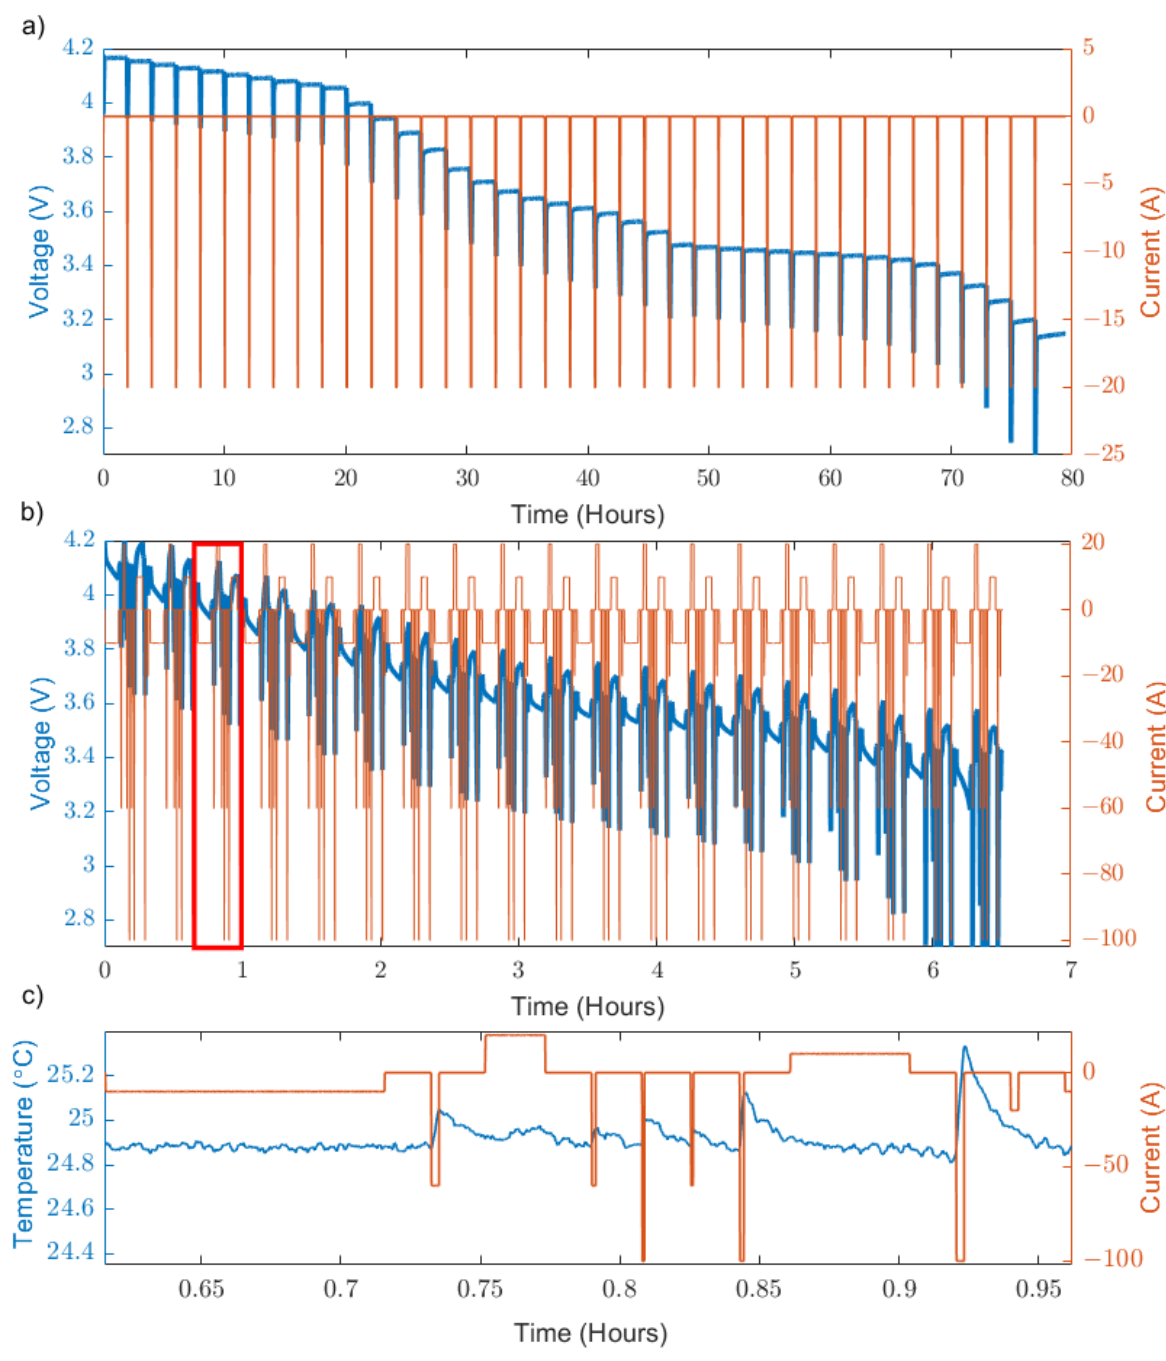
Figure 2. ( a ) GITT profile applied across the full voltage window of the cell (4.2–2.7 V) ( b ) AMPP profile applied across the entire voltage window of the cell, 4.2–2.7 V. ( c ) Detailed view of the Current and Temperature profile of the AMPP technique from the segment show in the red box of ( b ).